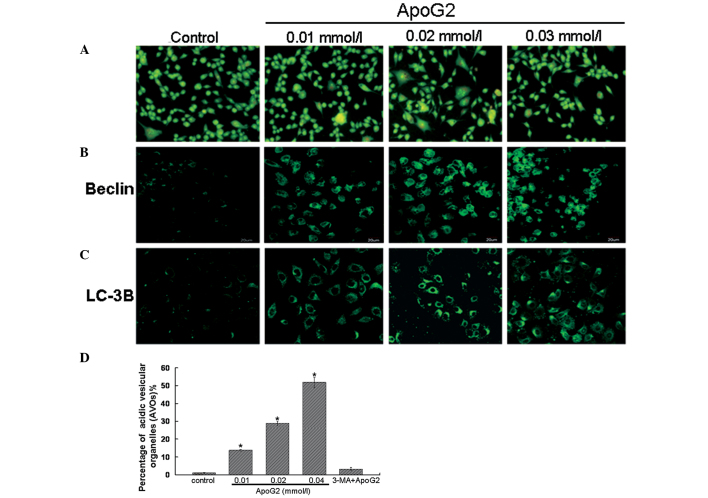
Autophagy analysis by acridine orange staining and expression levels of beclin-1 and LC-3B by immunocytochemistry. The cells were treated with ApoG2 or ApoG2 and 3-MA for 48 h prior to analysis. (A) Acridine orange staining results. (B) Expression of beclin-1. (C) Expression of LC-3B. (D) Quantitative flow cytometry results of autophagy. *P<0.05, compared with the control. ApoG2, apogossypolone; 3-MA, 3-methyladenine.